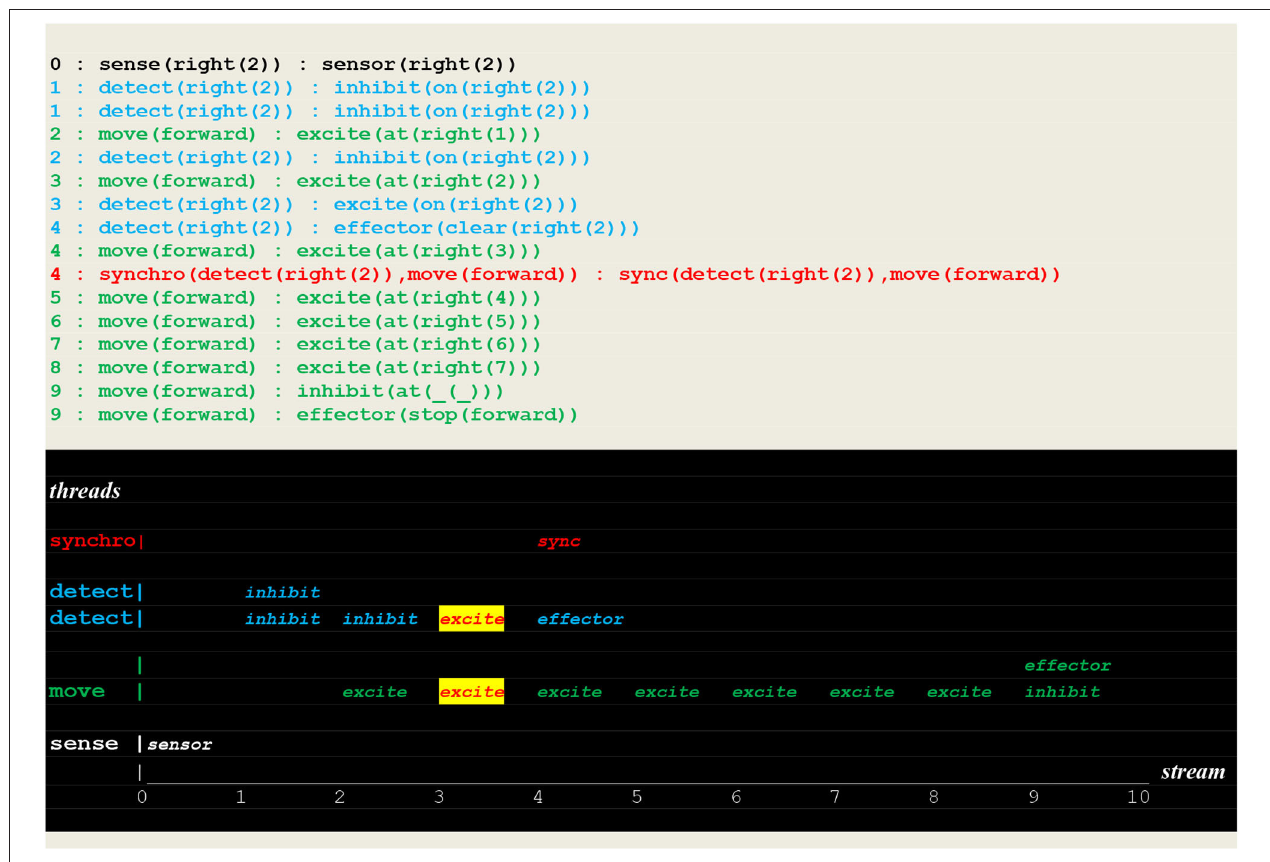
FIGURE 18 | Execution trace of applying a rule. This run is similar to the one of Figure 15 , but with a fire at different location in the same direction.